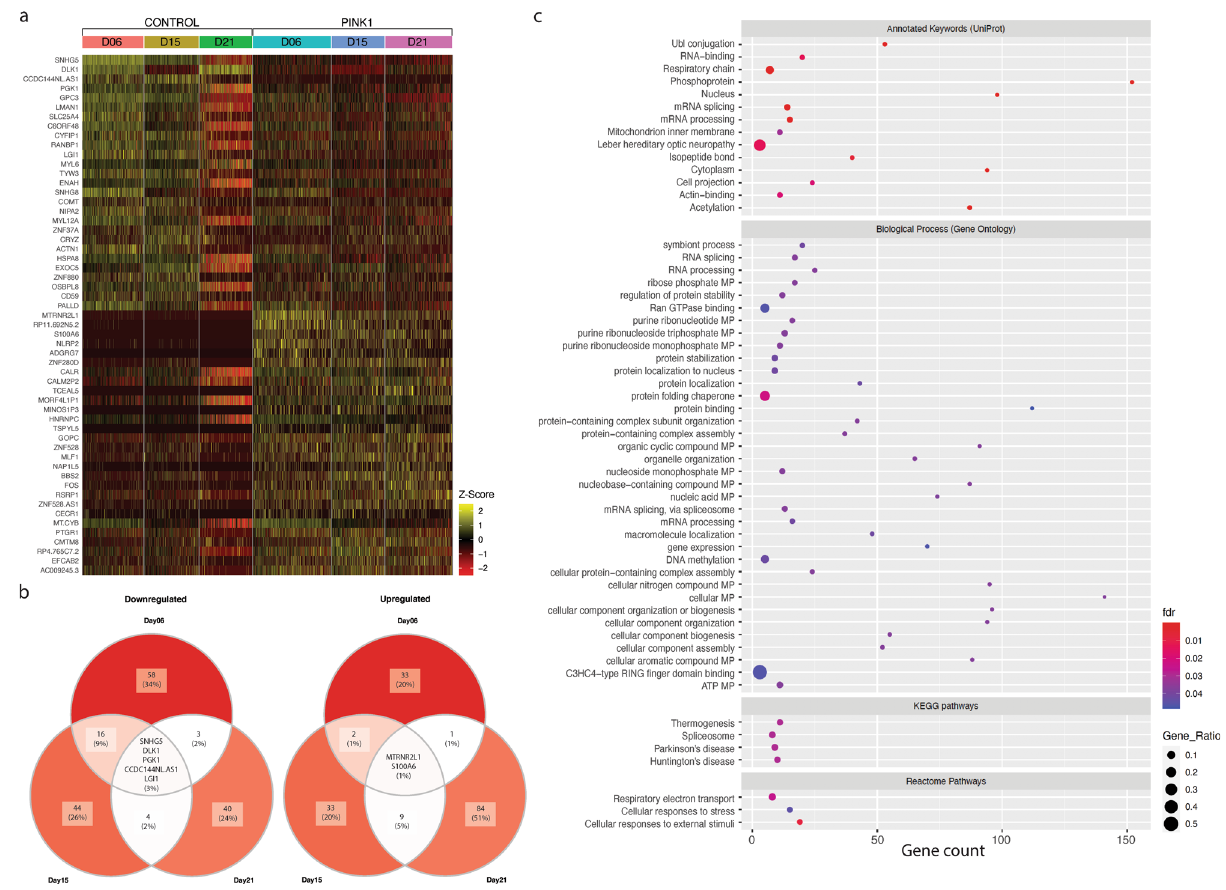
Fig. 5 Differentially expressed genes (DEGs) in a cell line homozygous for a mutation in the PINK1 gene, compared to a control cell line, at three timepoints during the differentiation of mDA neurons (D6, D15, and D21). a Heatmap of the top DEGs. Each column corresponds to a timepoint for either control or PINK1 cells; each row shows the expression of one gene in individual cells. Colors correlate to normalized counts ( z -score, centered, and scaled) of the indicated genes. b Top DEGs. The minimum fold change was increased to highlight the top differentially expressed genes. We identi fi ed the top 56 genes as our group A (Table 2); here we show the top fi ve upregulated genes (left Venn diagram) and the top three downregulated genes (right Venn diagram). c Enrichment analysis performed using the STRING 59 database. The top KEGG pathway associated with this dataset is Parkinson ’ s disease. The other three KEGG pathways identi fi ed were Spliceosome, Huntington ’ s disease, and Thermogenesis. Details are listed in Supplementary Data 5. The gene expression matrix used for the downstream analysis consisted of 4495 cells (39,194 genes) and differential expression analysis resulted in 292 DEGs, which were used to perform the enrichment